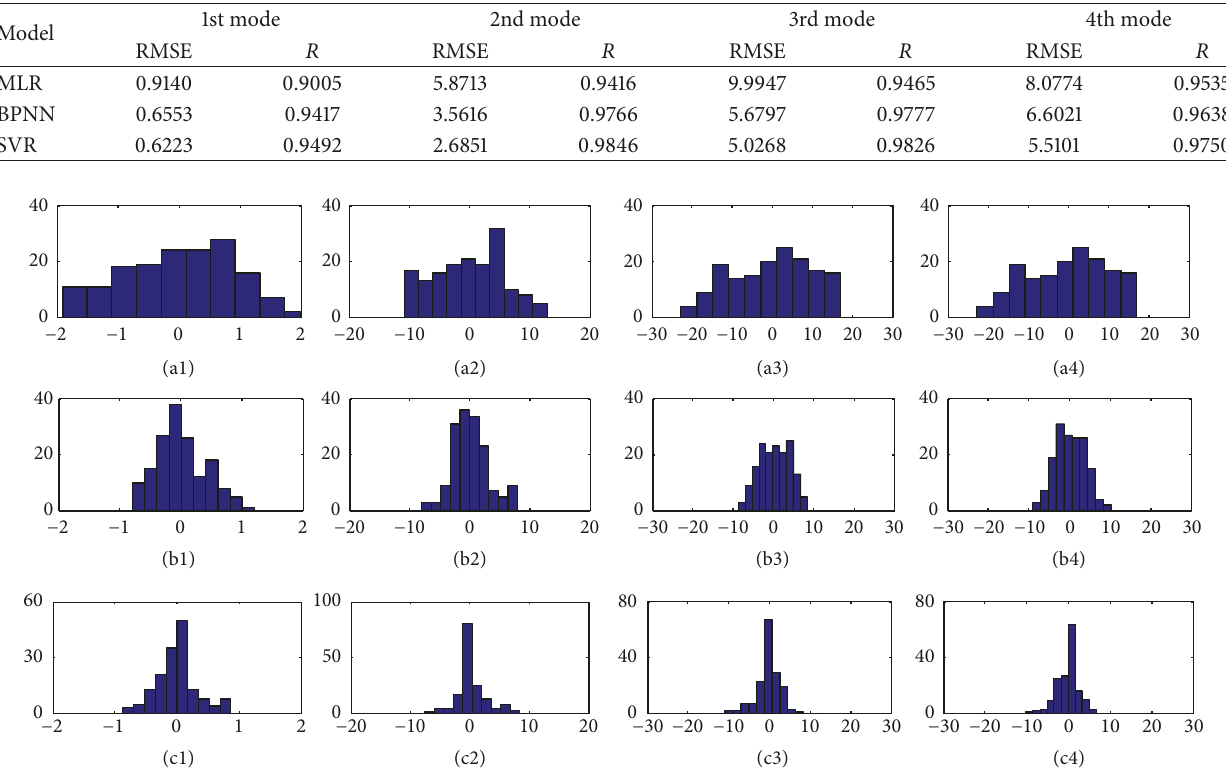
Table 3: RMSE and 𝑅 values of predicted modal frequencies.